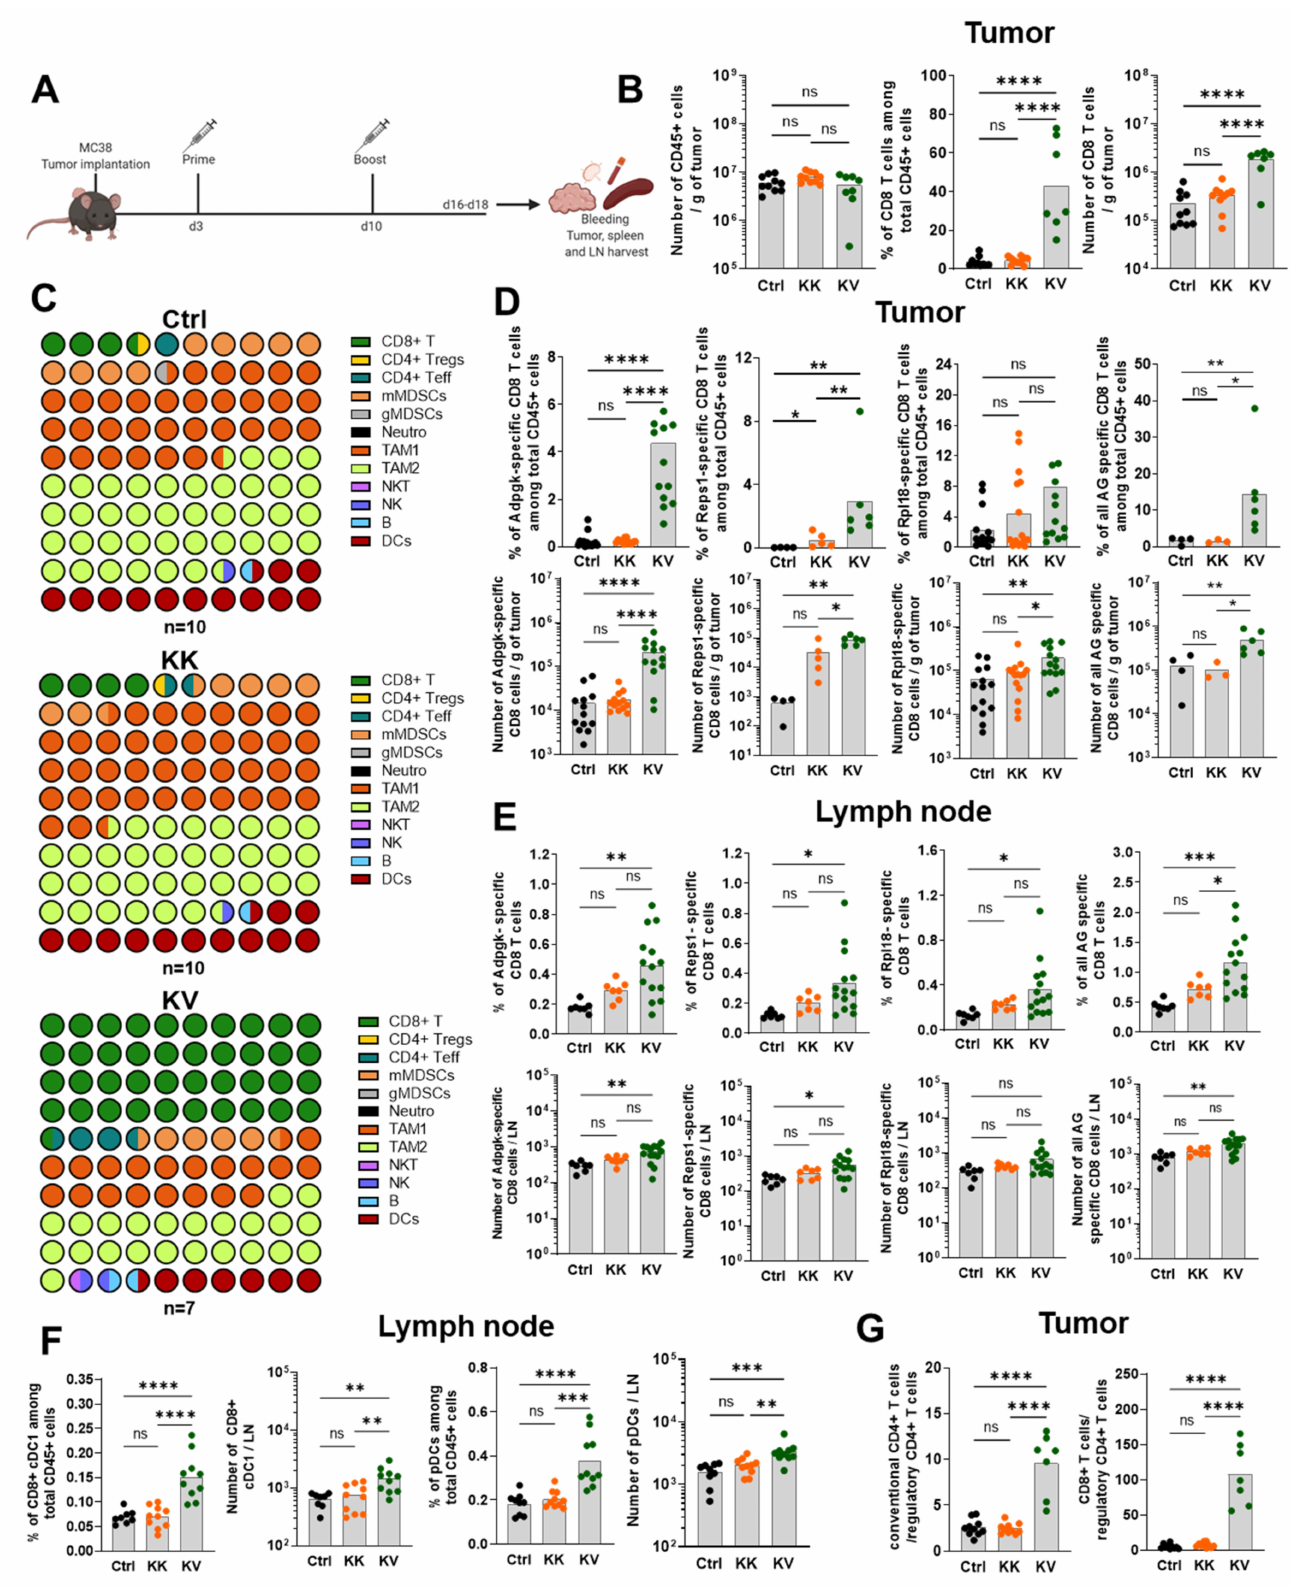
Figure 4. Increased antigen-specific CD8+ T cell in tumor and tumor dLNs and elevated intranodal CD8+ cDC1s and pDCs of heterologous prime-boost-treated MC-38 tumor-bearing C57BL/6 mice. ( A ) Treatment schedule of either